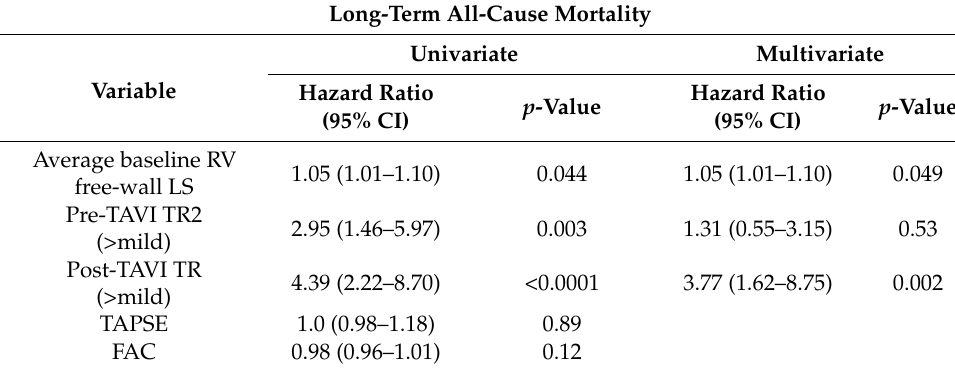
Table legend: RV: right ventricular, LS: longitudinal strain, TAVI: transcatheter aortic valve implantation, TR: tricuspid regurgitation. FAC: fractional area change, TAPSE: tricuspid annular plane systolic excursion. Regression analysis of post-interventional echocardiographic parameters of RV func- tion did not reveal any significant predictors of long-term all-cause mortality except for moderate to severe tricuspid regurgitation (HR 4.39, 95% CI [2.22–8.70], p =